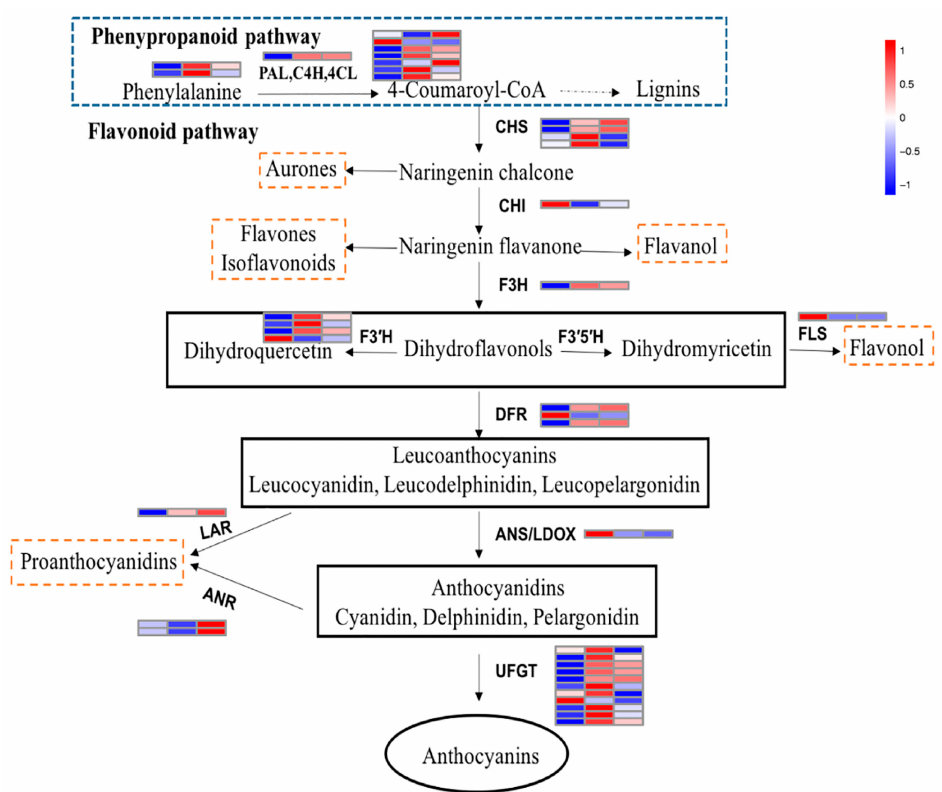
Figure 6. A schematic representation of the flavonoid biosynthetic pathway leading to anthocyanins. The expression pattern of each structural gene involved in anthocyanin synthesis in BL, WL, and RL is arranged from left to right. WL, RL, and BL indicates samples treated by white light, red light, and blue light, respectively. The color scale represents re-processed log10 (FPKM+1) using Pheatmap, representing the relative expression level. The expression variance for each gene is indicated by colors ranging from low (blue) to high